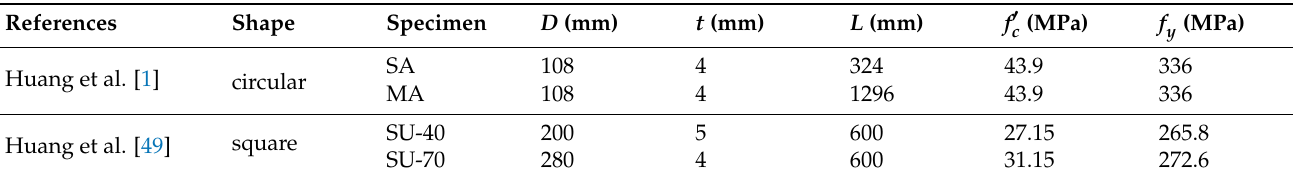
Table 7. Details of the specimens used for